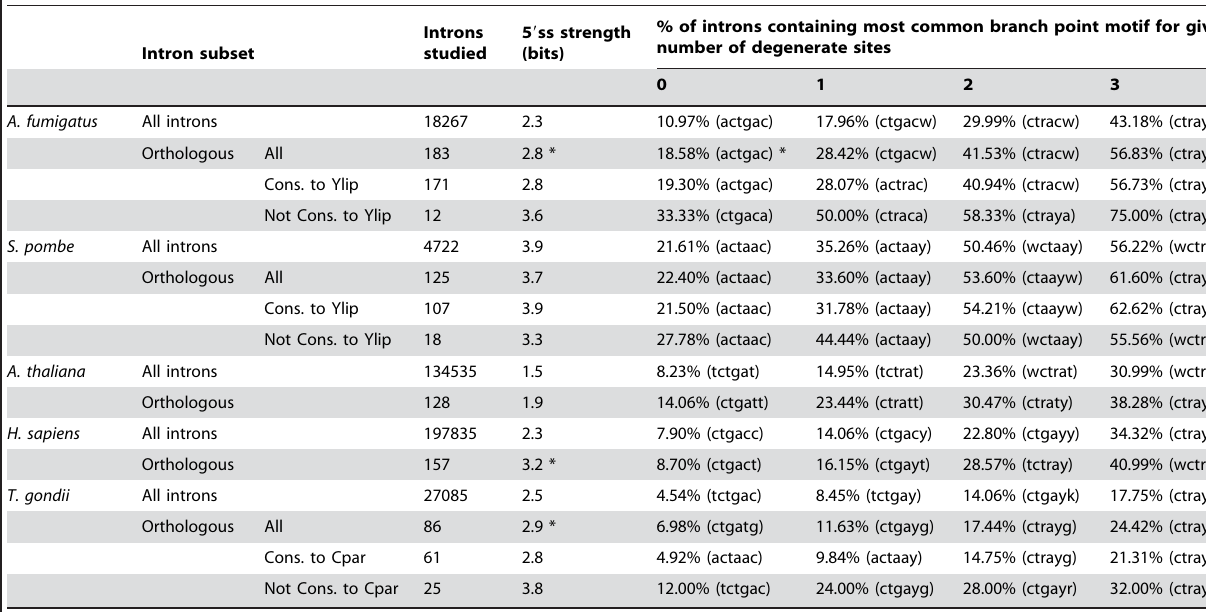
Table 4. Intron signal